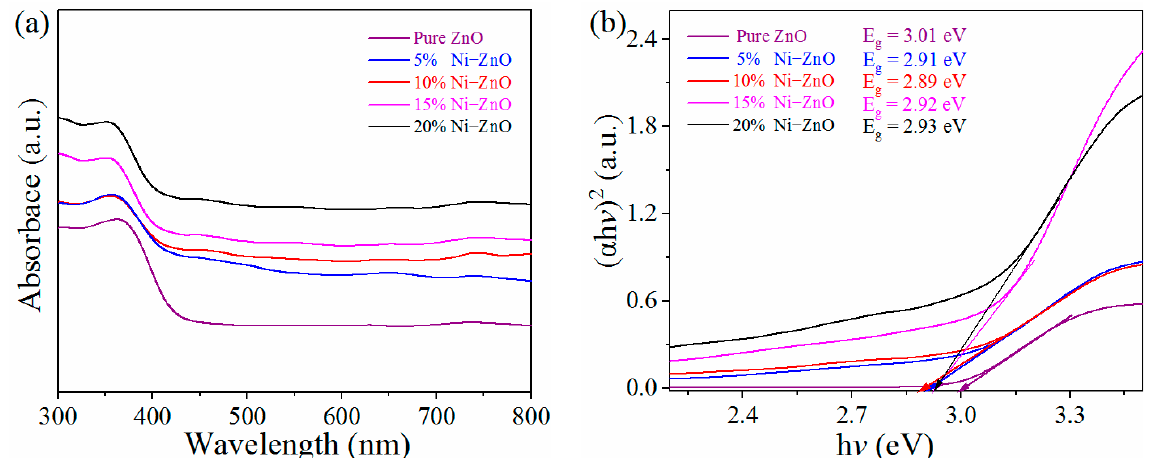
Figure 4. ( a ) UV-vis absorption spectra of the porous pure sea urchin-like ZnO and the porous urchin-like Ni-ZnO. ( b ) Bandgap determination from ( α h v ) 2 vs. h v of the porous pure sea urchin-like ZnO and the porous sea urchin-like Ni-ZnO.